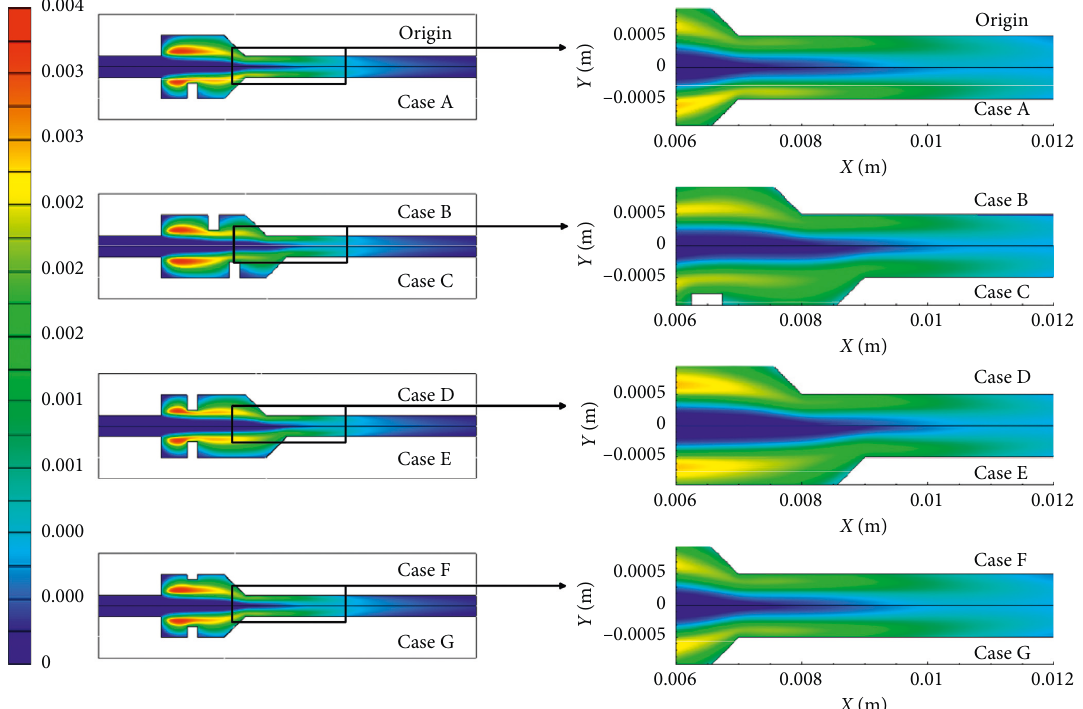
Figure 8: Mass fraction contours of OH in the different combustor; the inlet velocity is 10m/s.